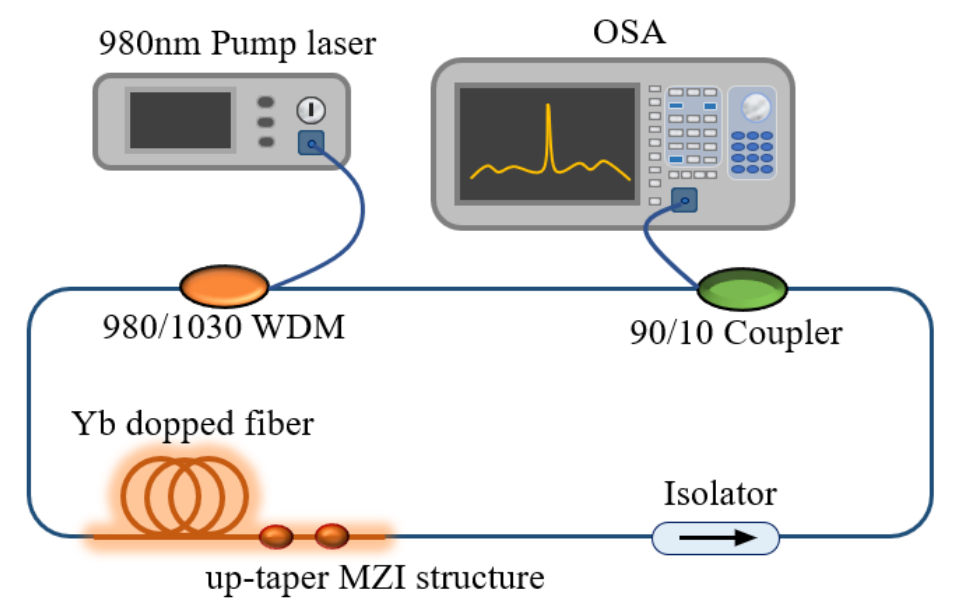
Figure 5. The intracavity sensing system of the FRL without extra sensing head.